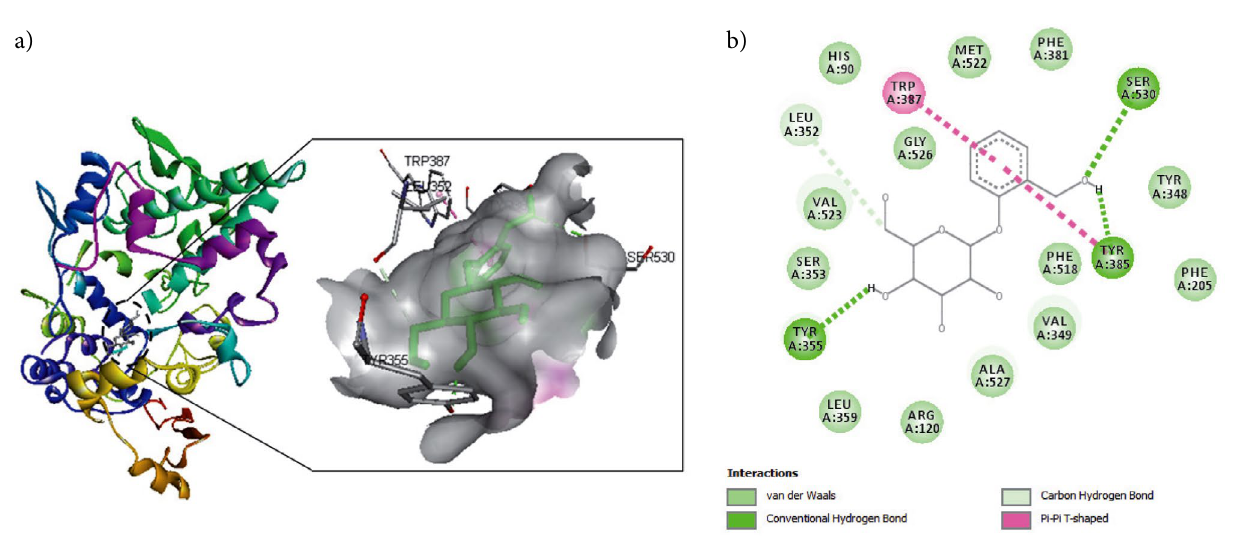
Figure 2. Active site of the COX-2 enzyme with salicin ( A ) 3D view; B ) 2D